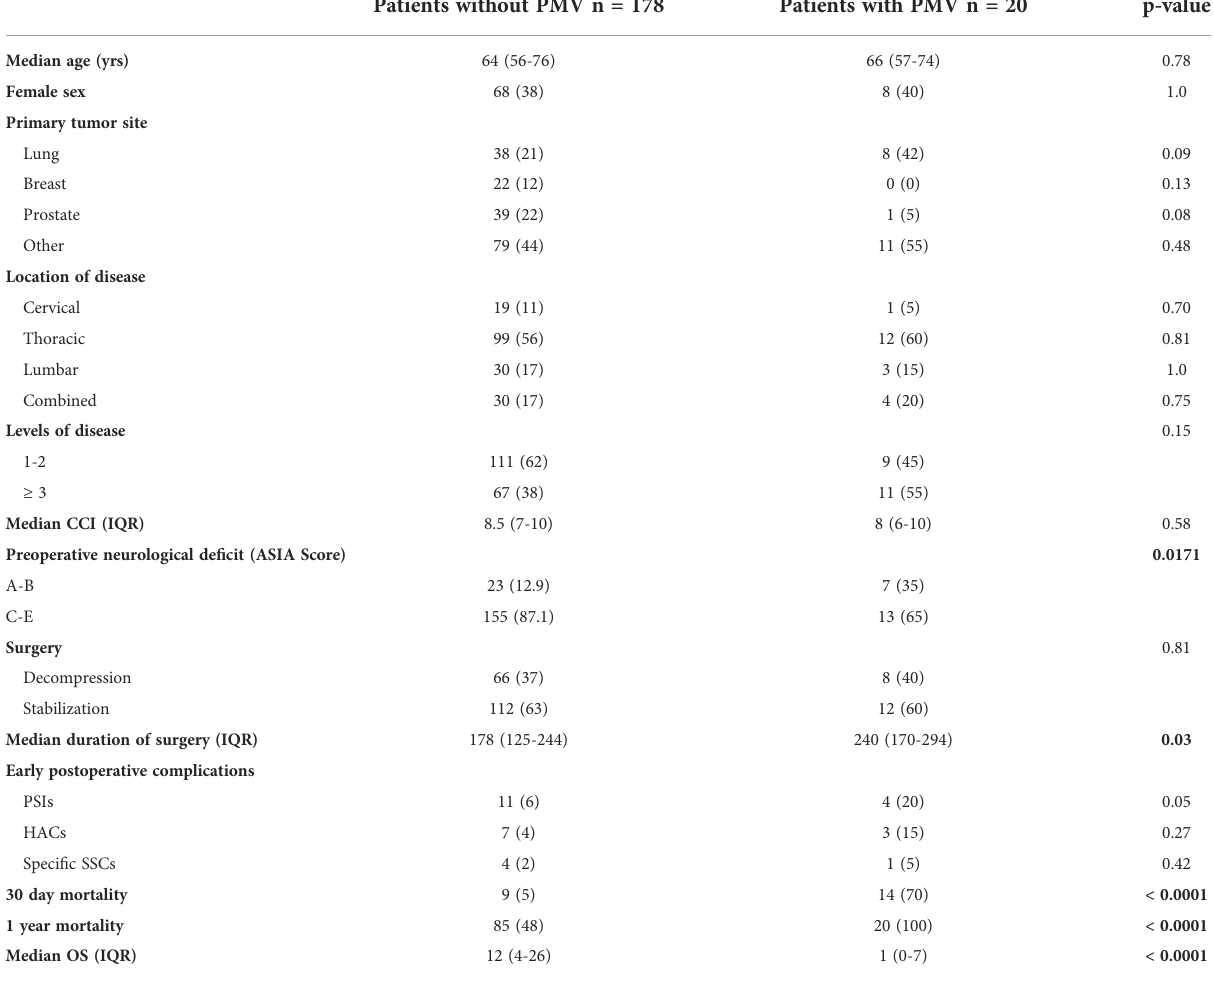
TABLE 2 Factors associated with postoperative PMV following surgery for spinal metastasis*.